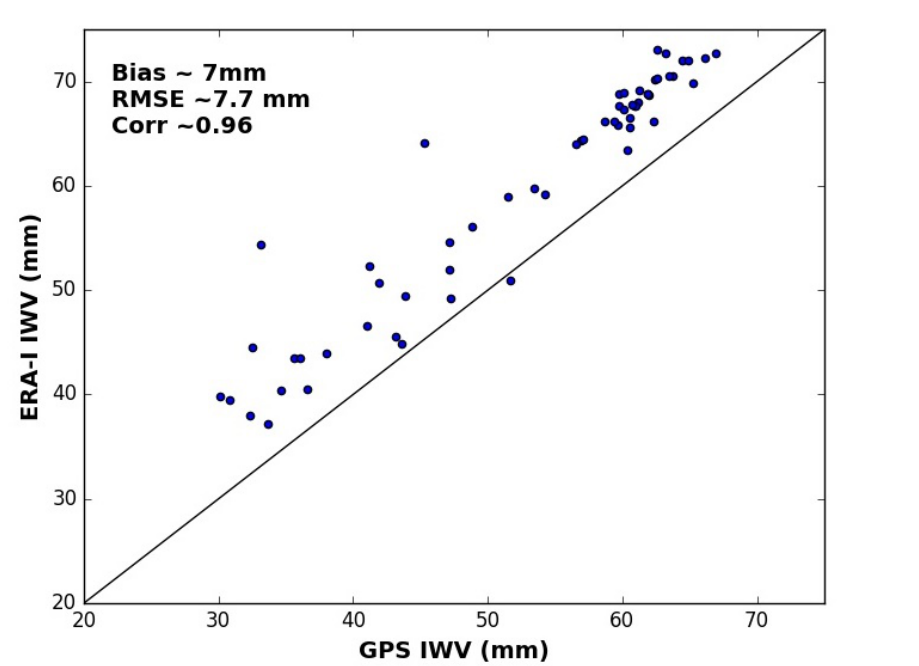
Figure 3. Comparison of IWV estimates from GPS cluster in Ahmedabad and ERA-I reanalysis data.